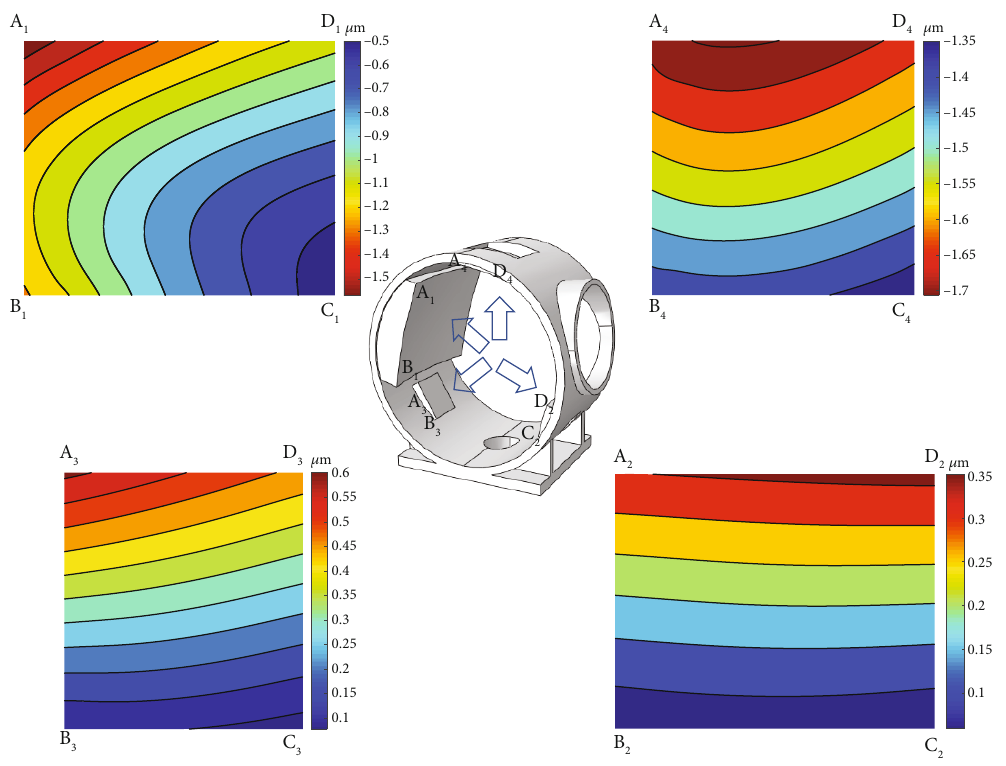
Figure 10: Deformation cloud diagram of di ff erent mirrors.